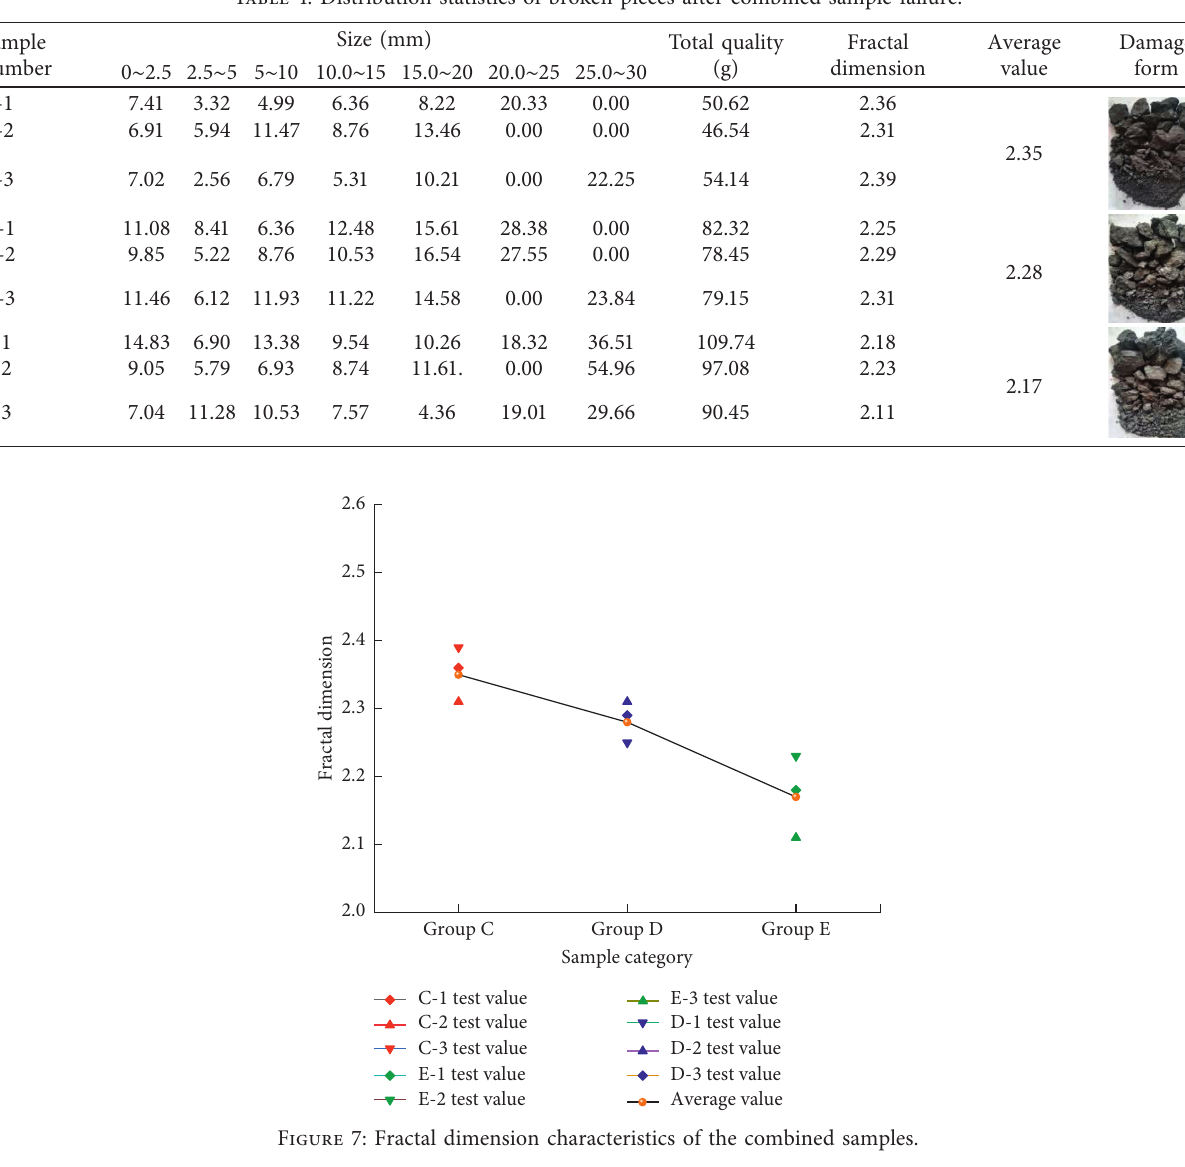
Table 4: Distribution statistics of broken pieces after combined sample failure.